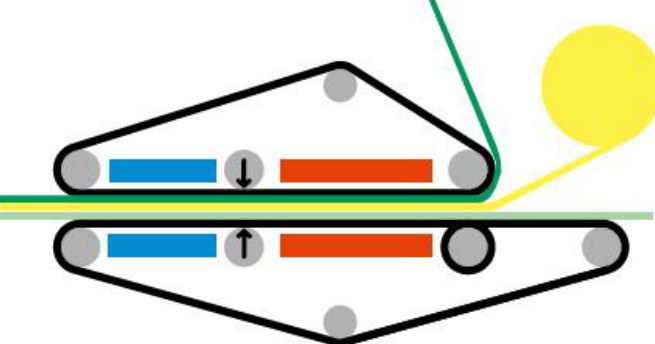
Figure 3. Illustration of the production line for manufacturing of sandwich panels, using slit adhesive films (adapted from [33]).